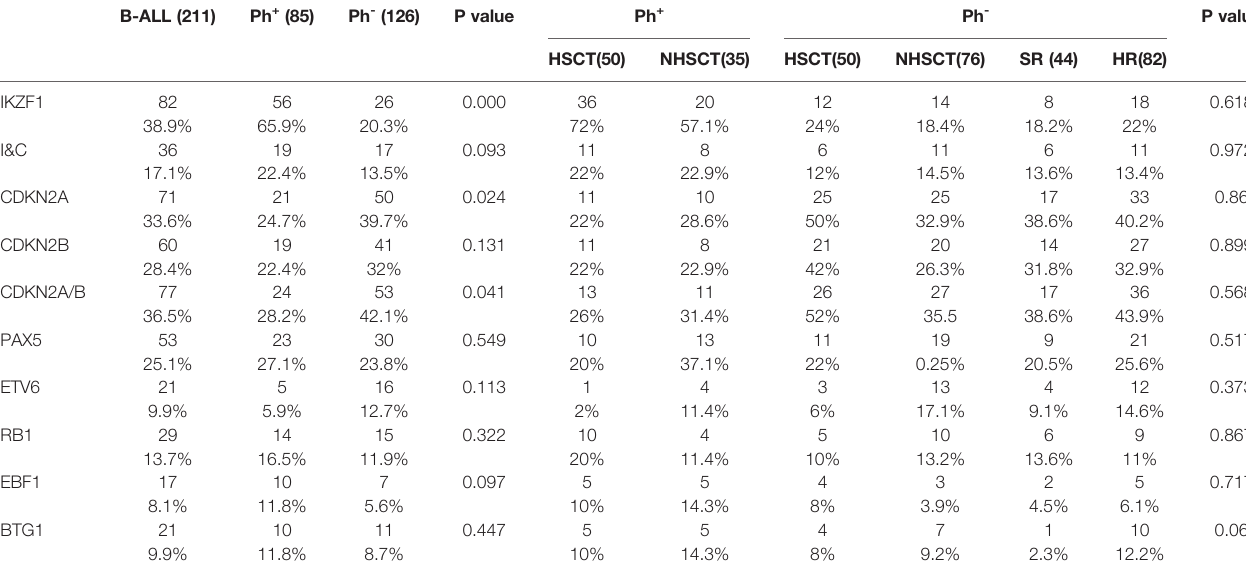
TABLE 2 | Prevalence of various gene deletions in different patient